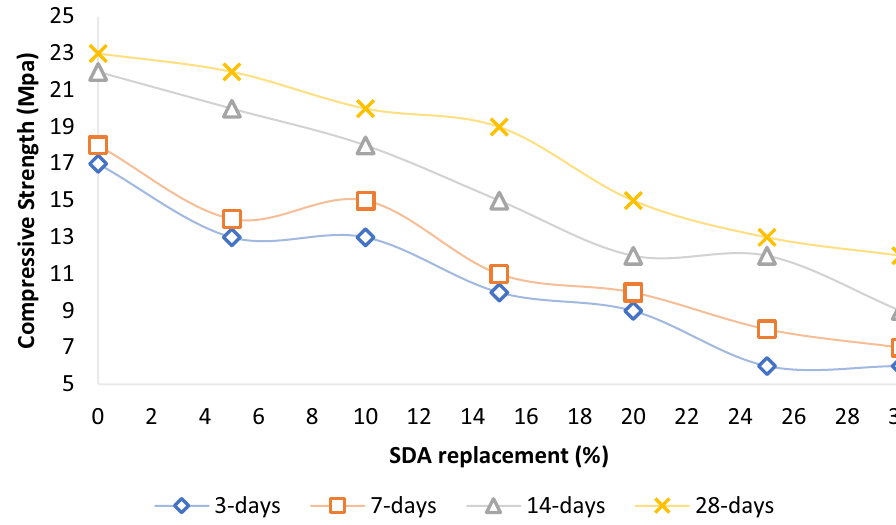
Fig. 8 Comparative effects of different hydration periods on the compressive strength of concrete mixed with varying proportions of SDA